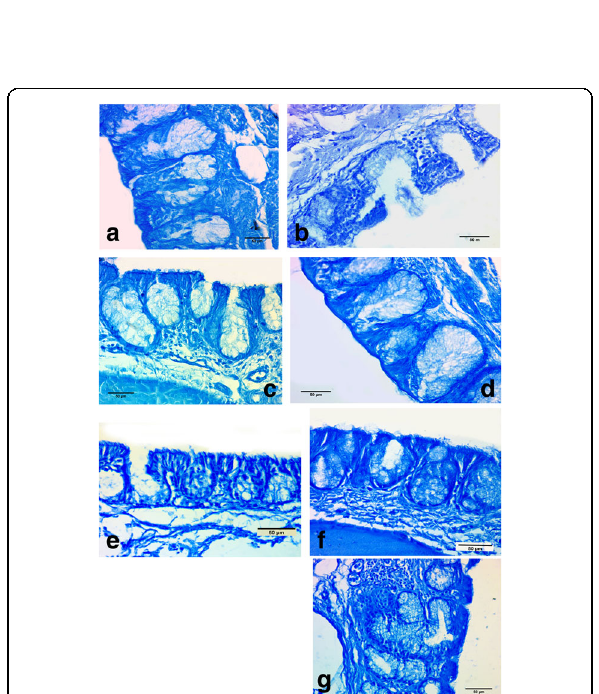
Fig. 15 Photomicrograph of a transverse section of choanal gland, a in kestrel with Alcian blue PH2, b in common moorhen with Alcian blue PH2, c in hoopoe withAlcian blue PH2, d in kestrel with Alcian blue PH1, e in common moorhen with Alcian blue PH1, f in hoopoe with Alcian blue PH1, and g in common moorhen with Alcian blue